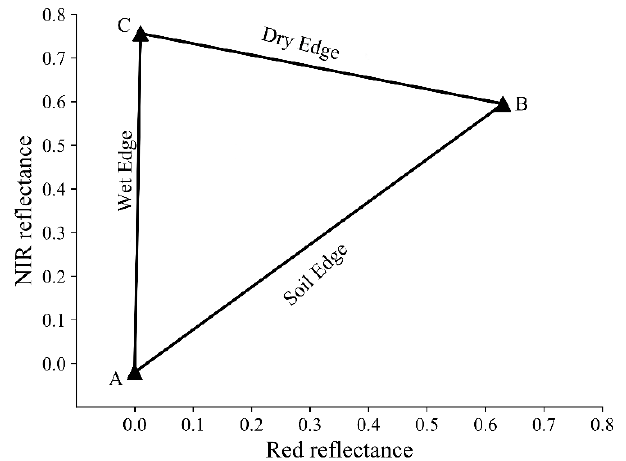
Figure 7. The definition of the triangle edges. AB is the soil edge, AC is the wet edge, and BC is the dry edge. All pixels are distributed in this triangular region in the NIR–Red spectral space.